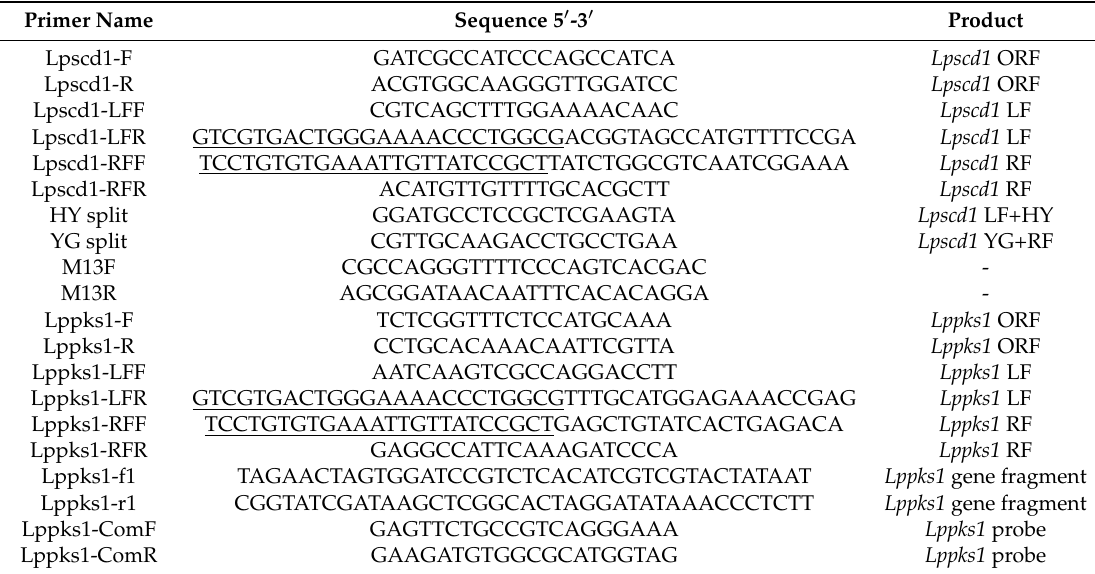
Table 1. Details of primer sequences used in this